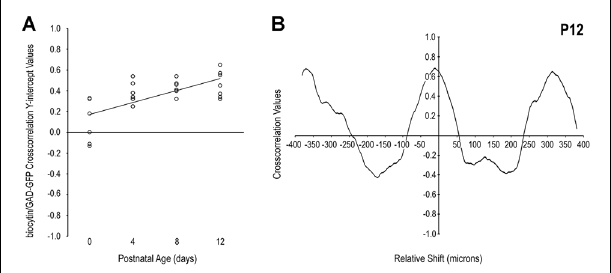
FIGURE 3 | Quantification of LCIC somatosensory patterns relative to GAD modular expression over its early critical period. The positively sloped linear regression of cross-correlation y-intercept values with age (A) supports the observed developmental trend that somatosensory afferents become increasingly modular and align with emerging GAD-positive layer 2 modules. A representative P12 cross-correlation function (B) exhibits a distinctly positive y-intercept (significant signal matching) with nearly symmetrical off-origin maxima and minima that indicate generally similar periodic patterns at this